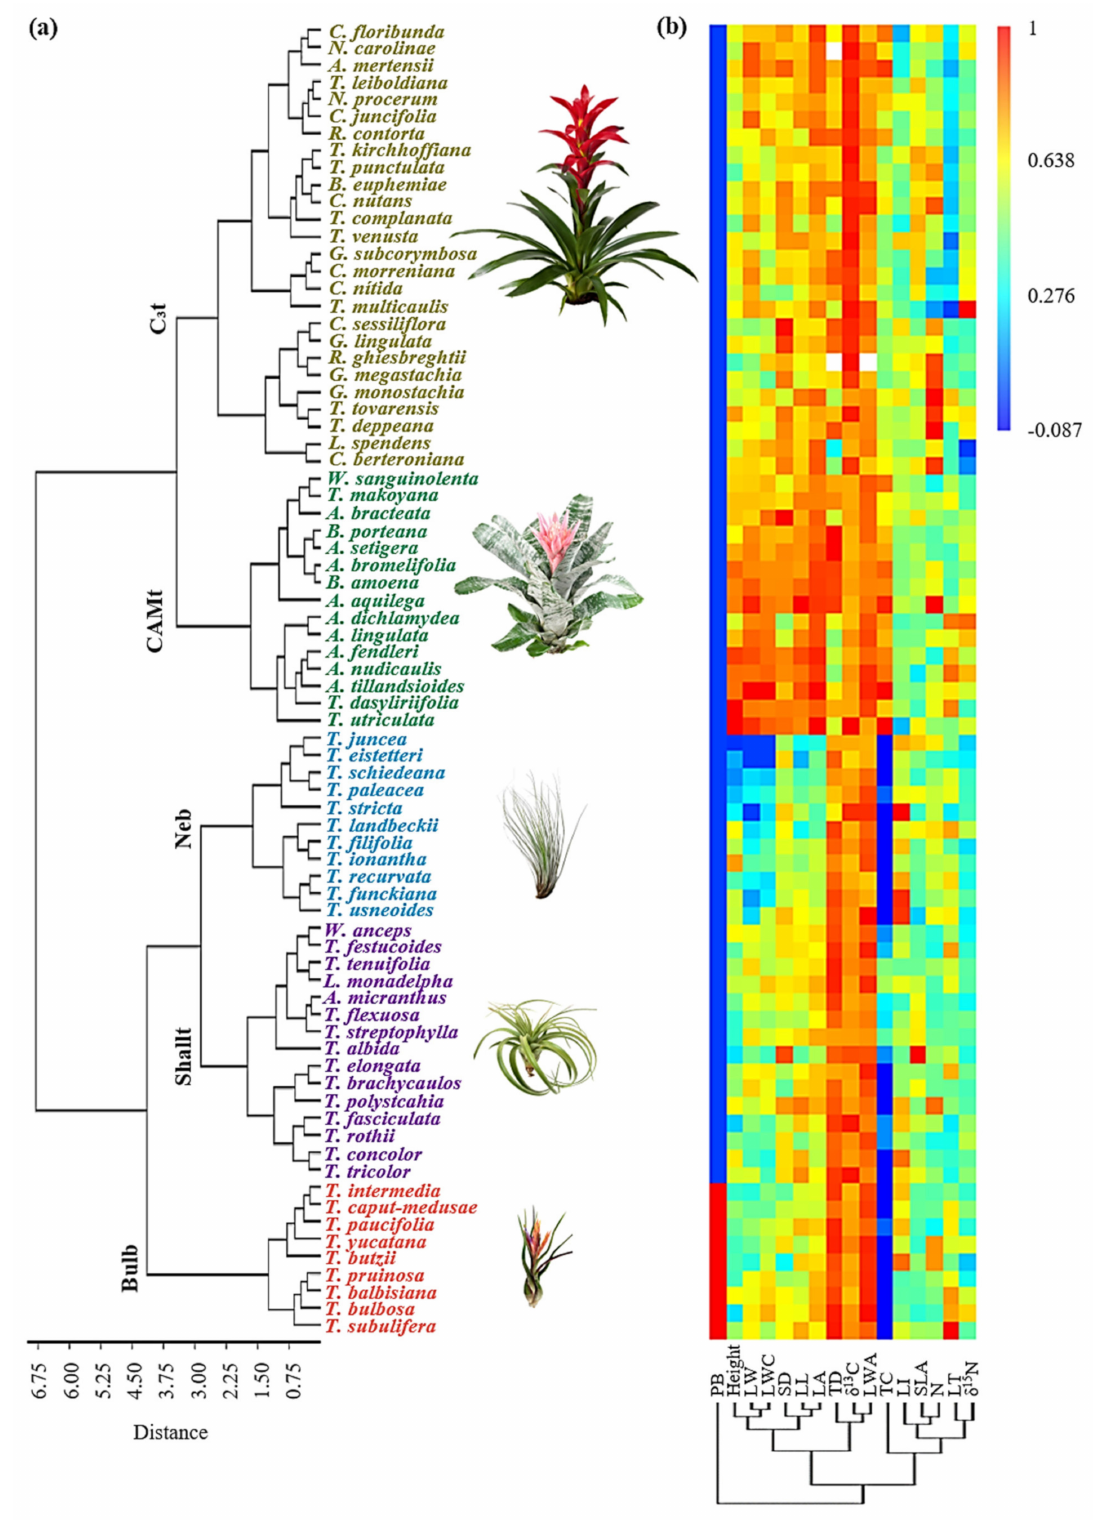
Figure 1. Hierarchical cluster analysis with Ward’s algorithm of major traits that separated 76 epi- phytic Bromeliaceae species into five functional groups. ( a ) Species clustering; ( b ) trait clustering and heatmap of species vs. functional traits. Neb = nebulophytes; Bulb = pseudobulbs; ShallT = shallow tanks; C3T = C 3 tanks, and CAMT = CAM tanks. For trait abbreviations, see Table